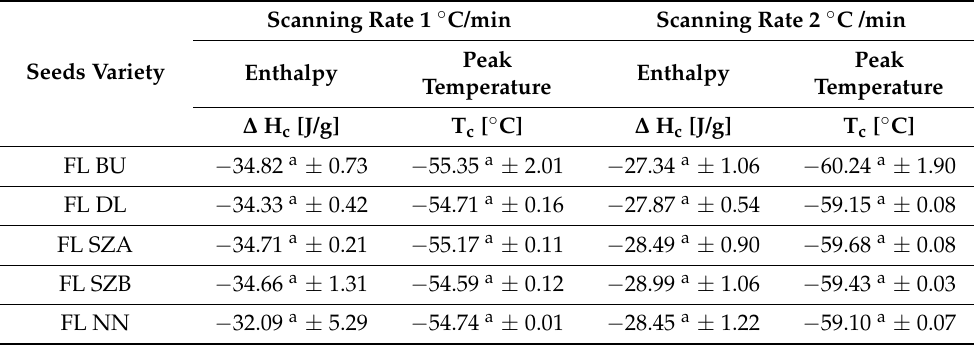
Figure 1. DSC crystallization curves of cold-pressed flaxseed oils from different cultivars obtained with various cooling rates: ( a ) Cooling rate 1 °C/min; ( b ) Cooling rate 2 °C/min. Table 3. Differential scanning calorimetry (DSC) thermodynamic parameters of crystallization process of different cultivars of cold-pressed flaxseed oils obtained by different scanning